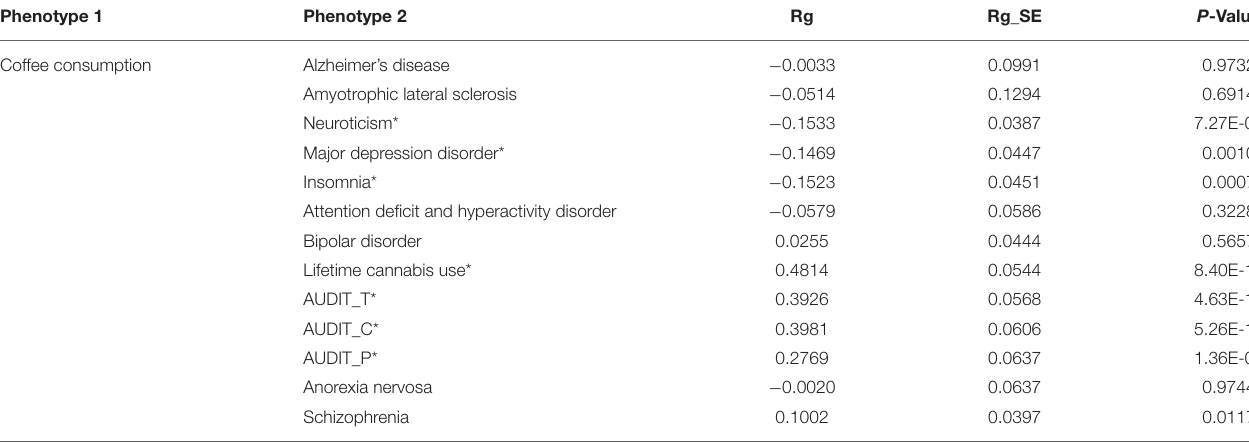
TABLE 1 | Genetic correlation between decaffeinated coffee consumption and neuropsychiatric